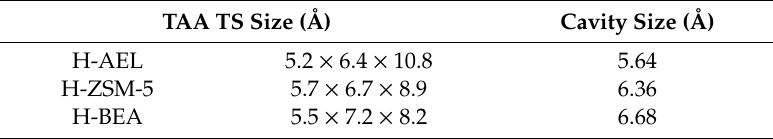
Table 4. Measured size of transition states of TAA and zeolite cavity